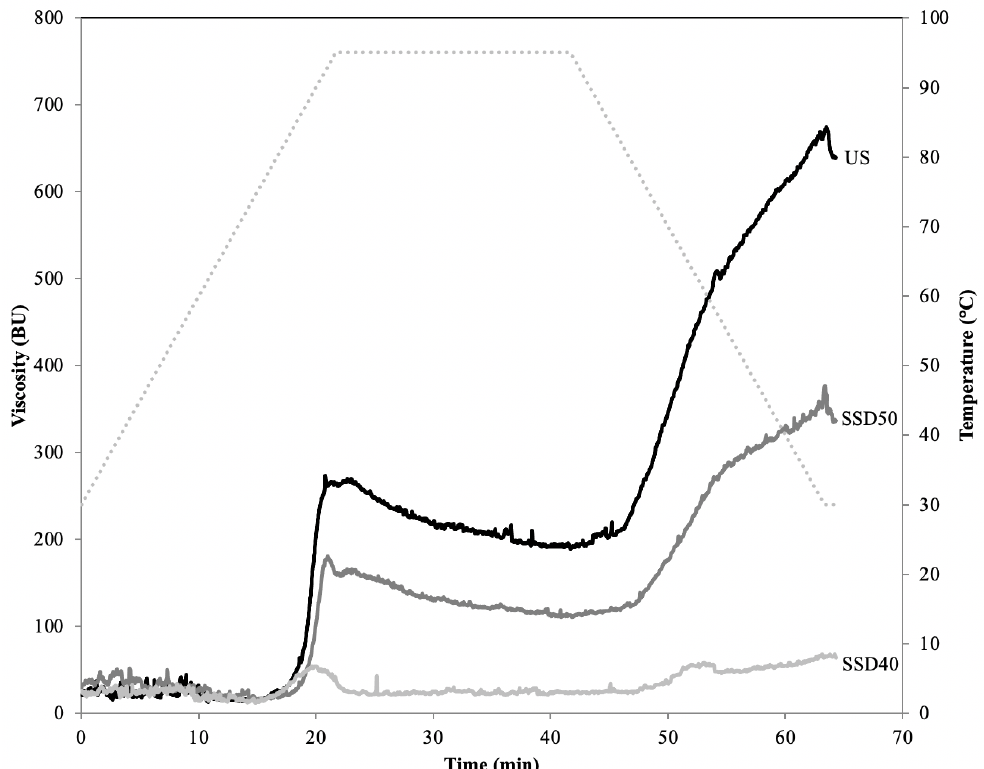
Figure 2. Pasting properties of sorghum flour samples measured by means of a Micro-Visco Amylograph. US, unsprouted sorghum flour; SSD50, flour from sprouted sorghum dried at 50 °C for 6 h; SSD40, flour from sprouted sorghum dried at 40 °C for 12 h.